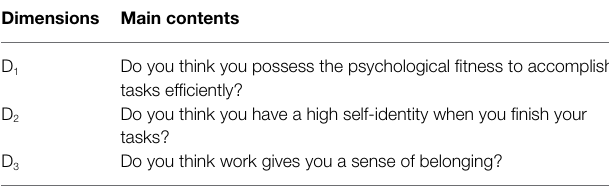
TABLE 4 | Psychological adaptation measurement.